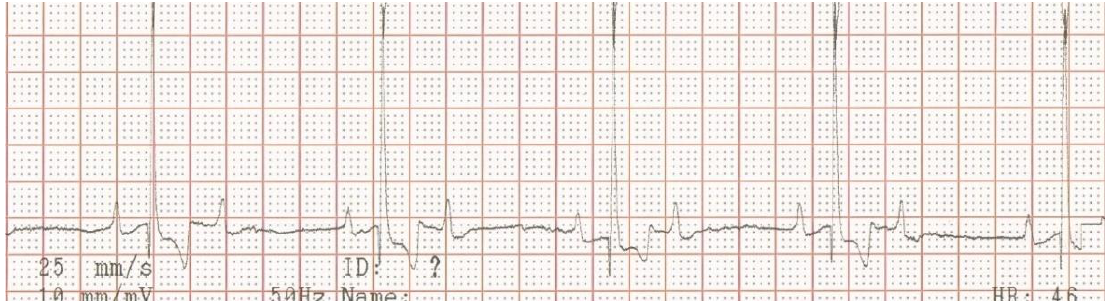
Figure 1. Surface electrocardiogram at initial presentation. Lead aVF shows a second-degree atrio- ventricular block, where every other P-wave is not conducted to the ventricles.